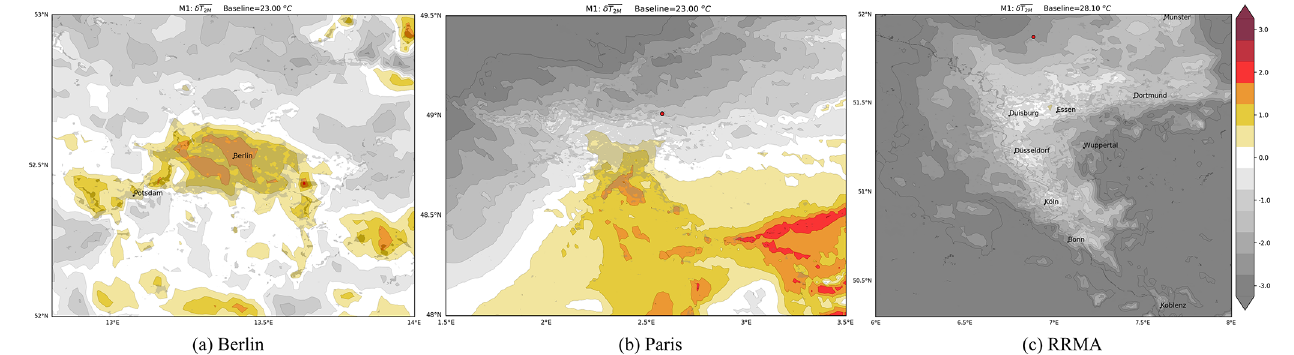
Figure 2. UHI calculated with M1 on the original grid (no interpolation) for Berlin, Paris and the Rhine-Ruhr Metropolitan Area (a–c) . The location of the weather station used as baseline is shown as a red dot, only when it is in the vicinity of the urban area.